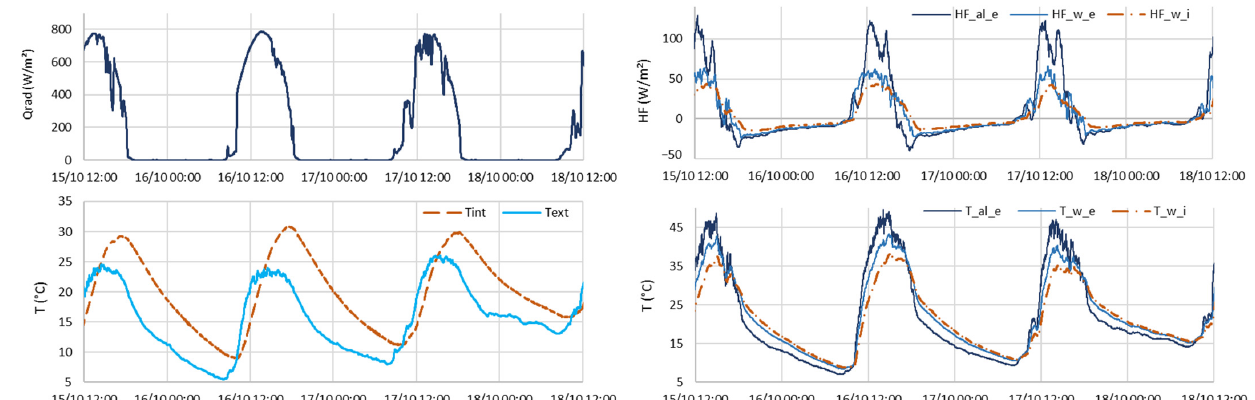
Figure 9. ( Top left ) Incident solar radiation, ( bottom left ) internal and external air temperatures, ( top right ) heat flows, and ( bottom right ) associated temperatures in the tested façade from November 15 to November 18, 2021. Test box oriented south, angle of flaps = 0°.